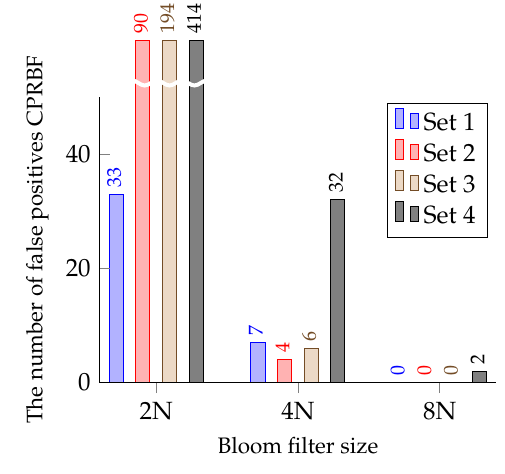
Figure 9. The number of false positives after